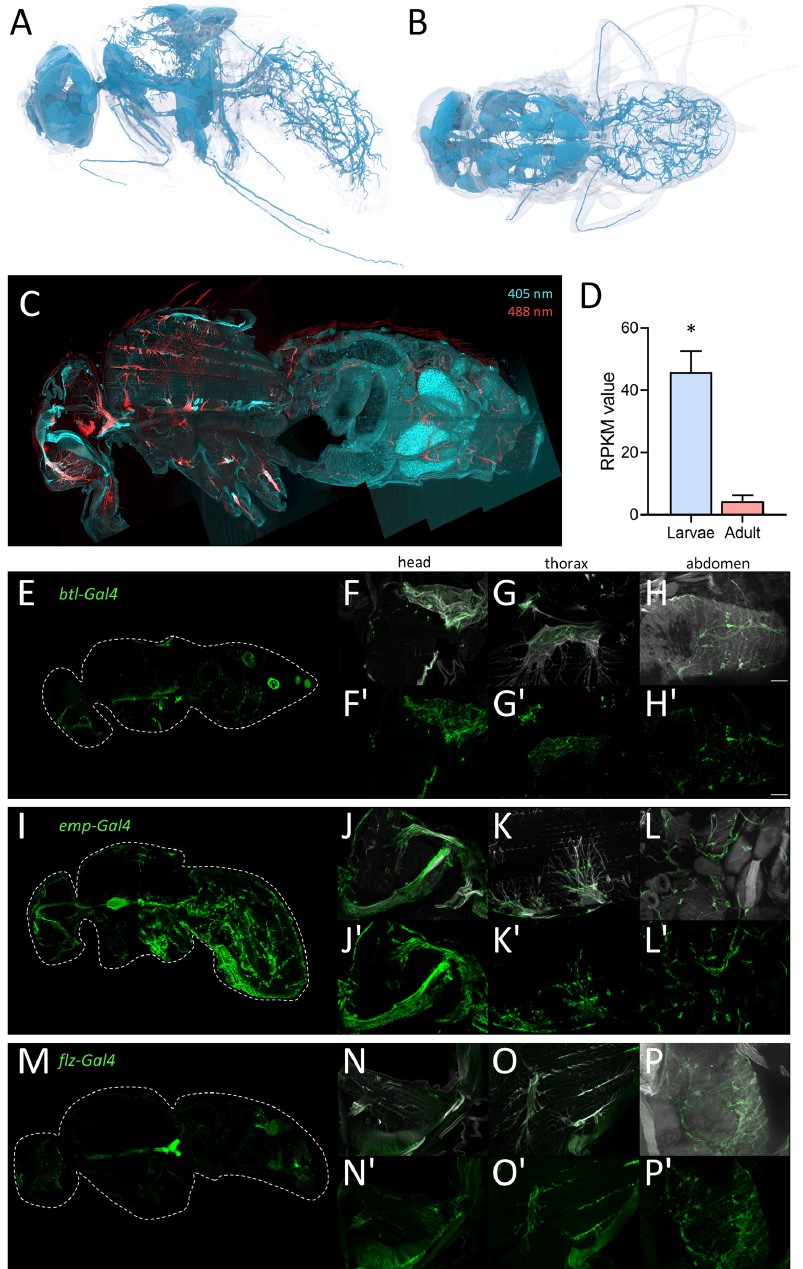
Figure 8. Morphology of the tracheal system in adult animals. ( A , B ) Structure of the tracheal system of adult flies as evaluated by micro-CT analysis, lateral ( A ) and dorsal view ( B ). To visualize tracheal structures in adults, we also employed autofluorescence ( C ). Here, longitudinal sections were analyzed with a confocal laser scanning microscope. The tracheal cells were excited by 405 nm (cyan; detection 460 nm) and 488 nm (red, detection 516 nm) lasers and detected for corresponding autofluorescence of the trachea in the head, thorax, and abdomen ( C ). ( D ) RPKM values of larval (blue) and adult (red) trachea for the canonical trachea driver gene btl . Asterisk indicates a differential gene expression based on the RNA-Seq analysis. ( E – P’ ) Expression of tracheal specific Gal4 driver lines in whole fly, head, thorax, and abdomen. Sagittal sections of btl-Gal4 ( E – H’ ), emp-Gal4 ( I – L’ ) and flz-Gal4 ( M – P’ ) crossed to UAS-GFP were stained with an anti-GFP nanobody. Tracheal air sacs and branches were simultaneously visualized with UV light (white; F – H , J – L , N – P ). Detailed magnification of the head ( F , F’ , J , J’ , N , N’ ), thorax ( G , G’ , K , K’ , O , O’ ) and abdomen ( H , H’ , L , L’ , P , P’ ) are shown. Scale = 50 µ